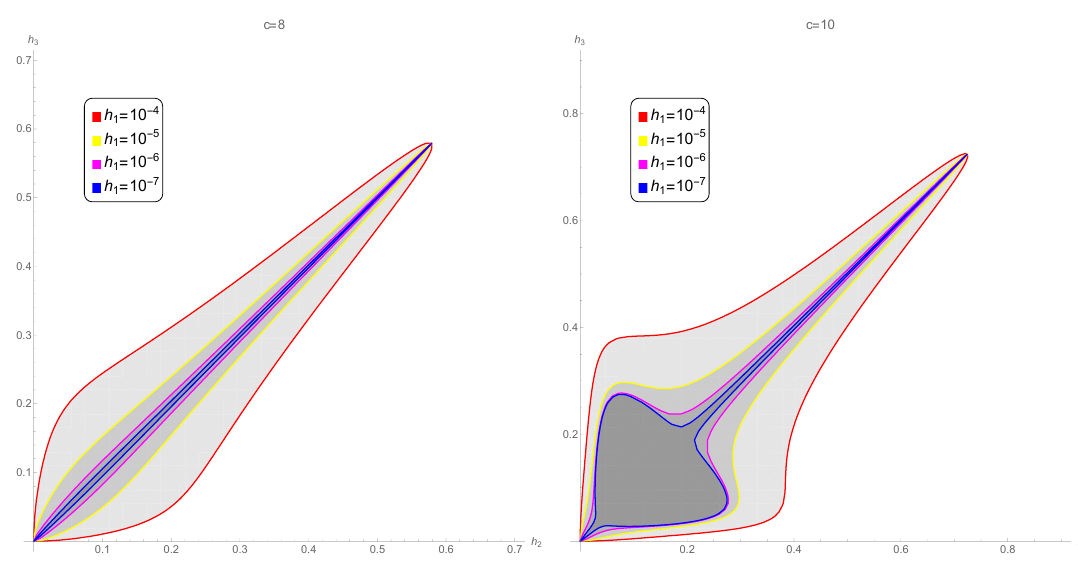
Figure 5 . Slices of the critical domain D (3) for c = 8 and c = 10 at small values of h 1 . For h c = 8, the critical domain D h intersects the h 1 = 0 plane only along a segment of the diagonal line h 2 = h 3 . This is not the case for c = 10.